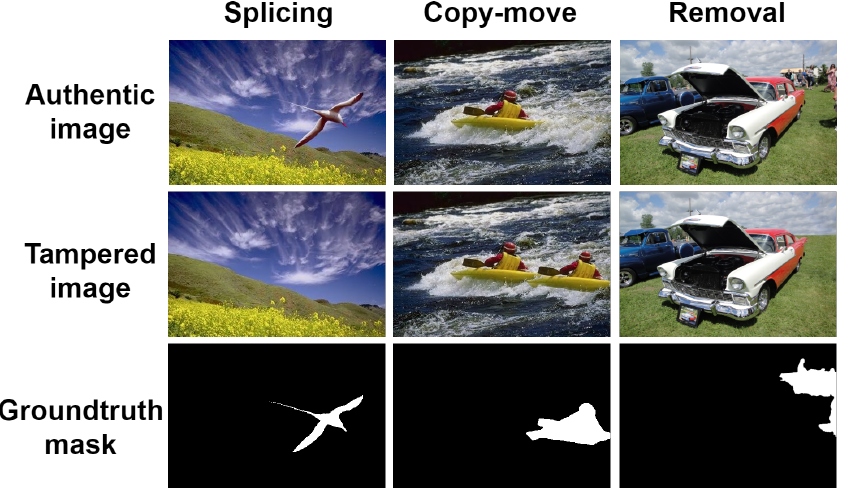
Figure 1. Examples of tampered images with different manipulations. From the ( left ) to ( right ) are the examples showing manipulations of splicing, copy-move and